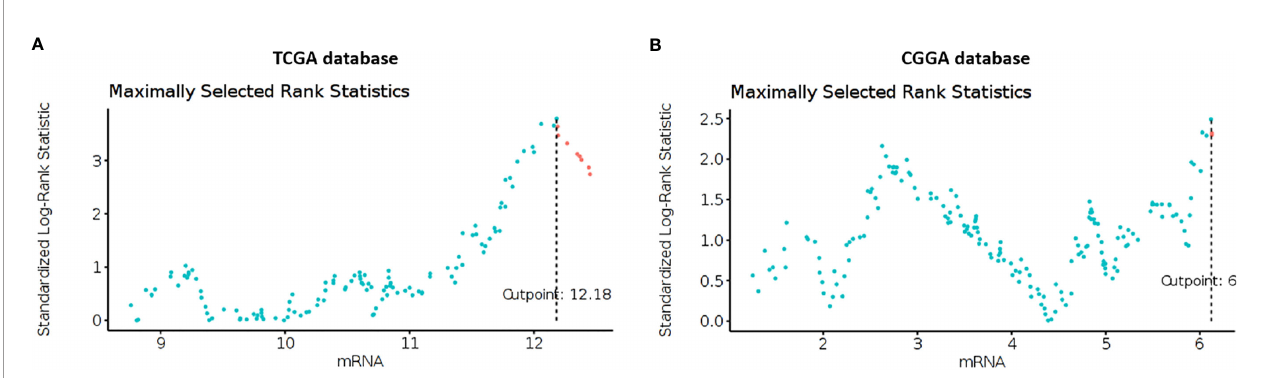
FIGURE 1 | (A, B) Maximally selected rank statistics plot of Cav-1 expression (mRNA) for GB patients determined from the TCGA (A) and CGGA (B) databases. The plots show the cut-point (mRNA level) that corresponds to the most optimal (statistically signi fi cant) discrimination with respect to outcome (i.e. survival). Light blue dots represent patients who have low expression of Cav-1, and pink dots represent patients who have high expression of